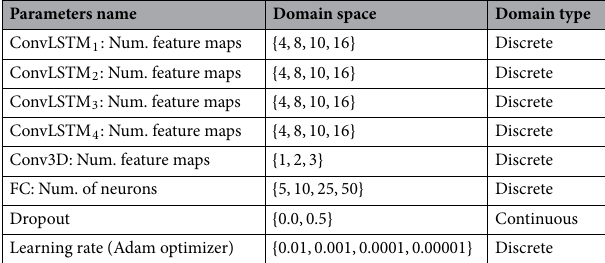
Table 2. Parameters of the ST-LSTM architecture for Bayesian